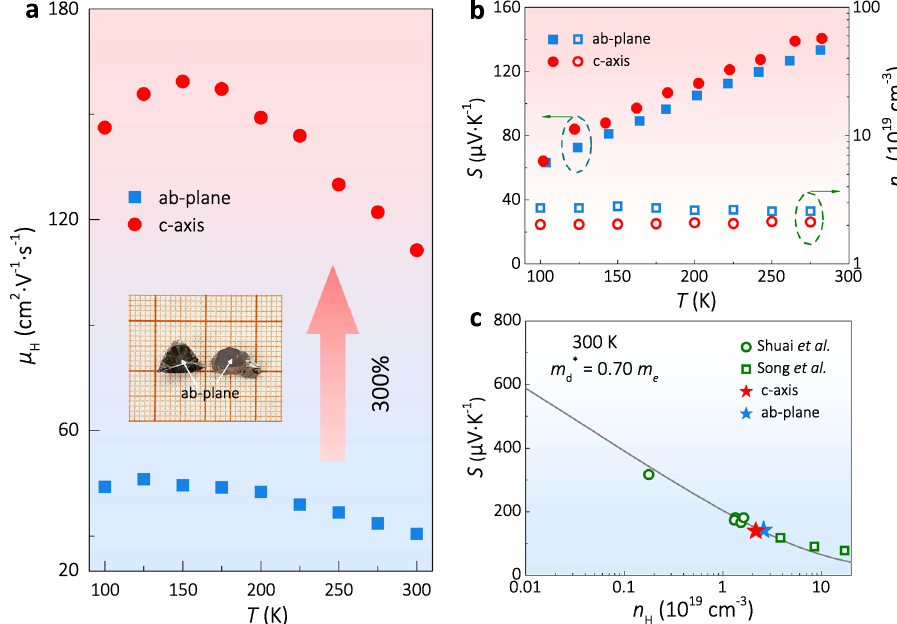
Fig. 3 The electrical properties of single crystal Mg 3 Sb 2 . Temperature dependences of a μ H , and b S and n H for the Ag-doped Mg 3 Sb 2 single crystal along c-axis and ab-plane. c Pisarenko plot showing the relationship between S and n H . The curve was calculated using the SPB model 18 with the m d * of 0.70 m e . The experimental data of the single crystals in this work and polycrystalline samples 32,33 are displayed. The inset in a is the optical image of the as-grown single crystals with a clear cleavage